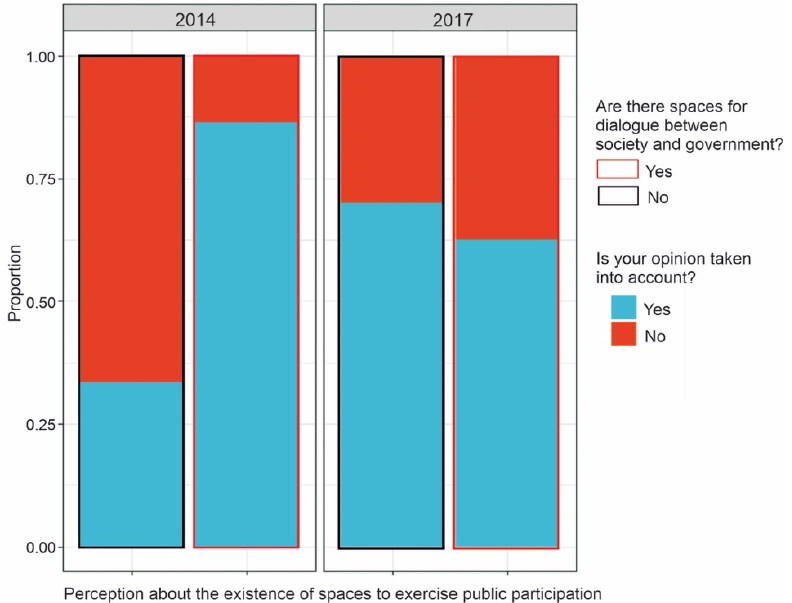
Figure 2. Perception about the existence of dialogue spaces and relevance of public opinion: (a) Left bars are the proportions of responses from the 2014 survey. Right bars represent the proportion associated with the responses from the 2017 survey. The responses about the existence of dialogue spaces between society and government correspond to red and black rectangles for “yes” and “no”, respectively, and responses for the question “Is your opinion taken into account?” correspond to blue and orange colors for “yes” and “no”, respectively.